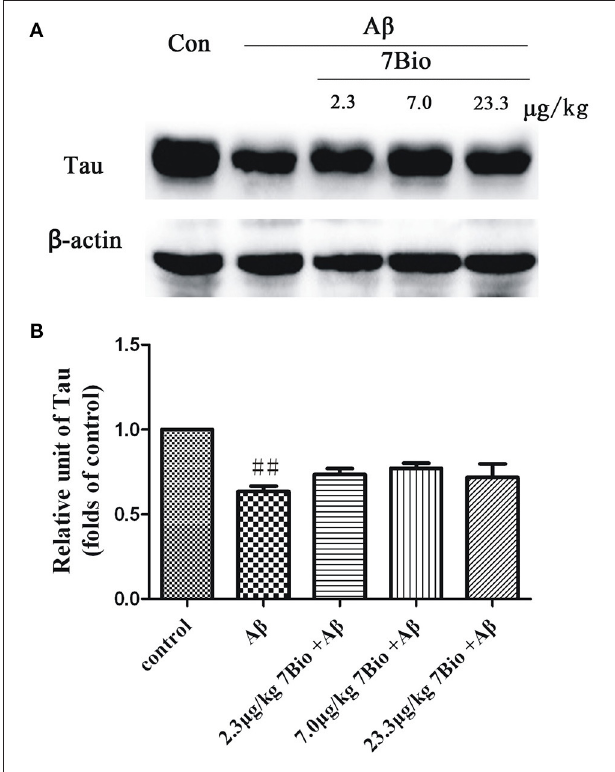
FIGURE 13 | 7Bio did not significantly prevent A β oligomer-induced decrease expression of tau protein in the hippocampal region of mice. At day 19 post-surgery, mice were sacrificed. (A) The expressions of tau protein and β -actin in the hippocampus were evaluated by Western blotting analysis. The quantitative analysis of levels of tau protein was shown in (B) . Data represent the mean ± SD ( n = 4); ## p < 0.01 vs. control group (one-way ANOVA and Tukey’s